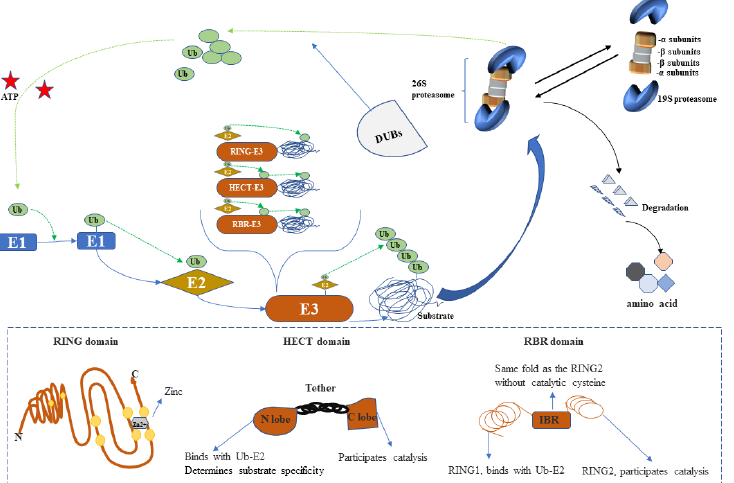
Figure 2. Depiction of the ubiquitin – proteasome system (UPS). The ubiquitin-activating conjugating and ligating enzymes are indicated as E1, E2, and E3. The 26S form of the proteasome catalyzes the degradation of ubiquitylated protein substrates. E3 enzymes are classified into three groups according to the presence of the HECT, RING, and RBR domains. Ubiquitin is transferred from E2 ligases to HECT or RBR-E3 ligases to ultimately ubiquitinate the substrate or directly ubiquitinate the substrate via the catalysis of RING-E3 ligases. Deubiquitination enzymes (DUBs) remove ubiquitin from substrates, which is recycled into cytosolic pools.